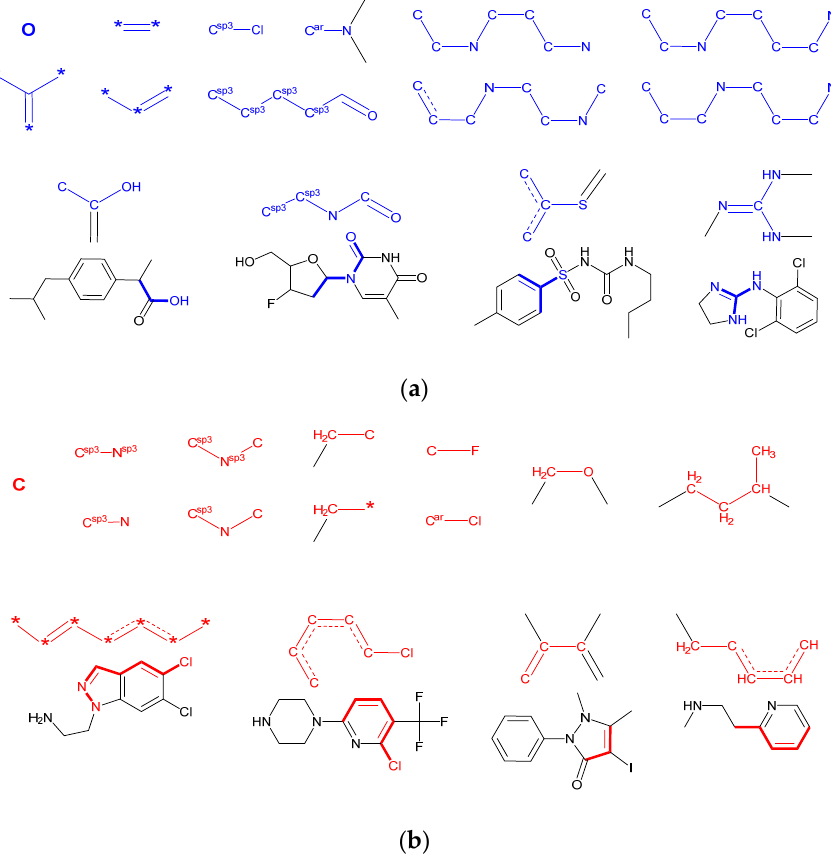
Figure 4. Fragments having the strongest negative ( a ) and positive ( b ) effect on the predicted value of BBB permeability of compounds. Fragments are highlighted in blue for negative and red for positive. Asterisk denotes any atom type; standalone atom symbol means any atom subtype compatible with the specified bond pattern. For more complex fragments, the examples of their occurrence in a structure are shown.